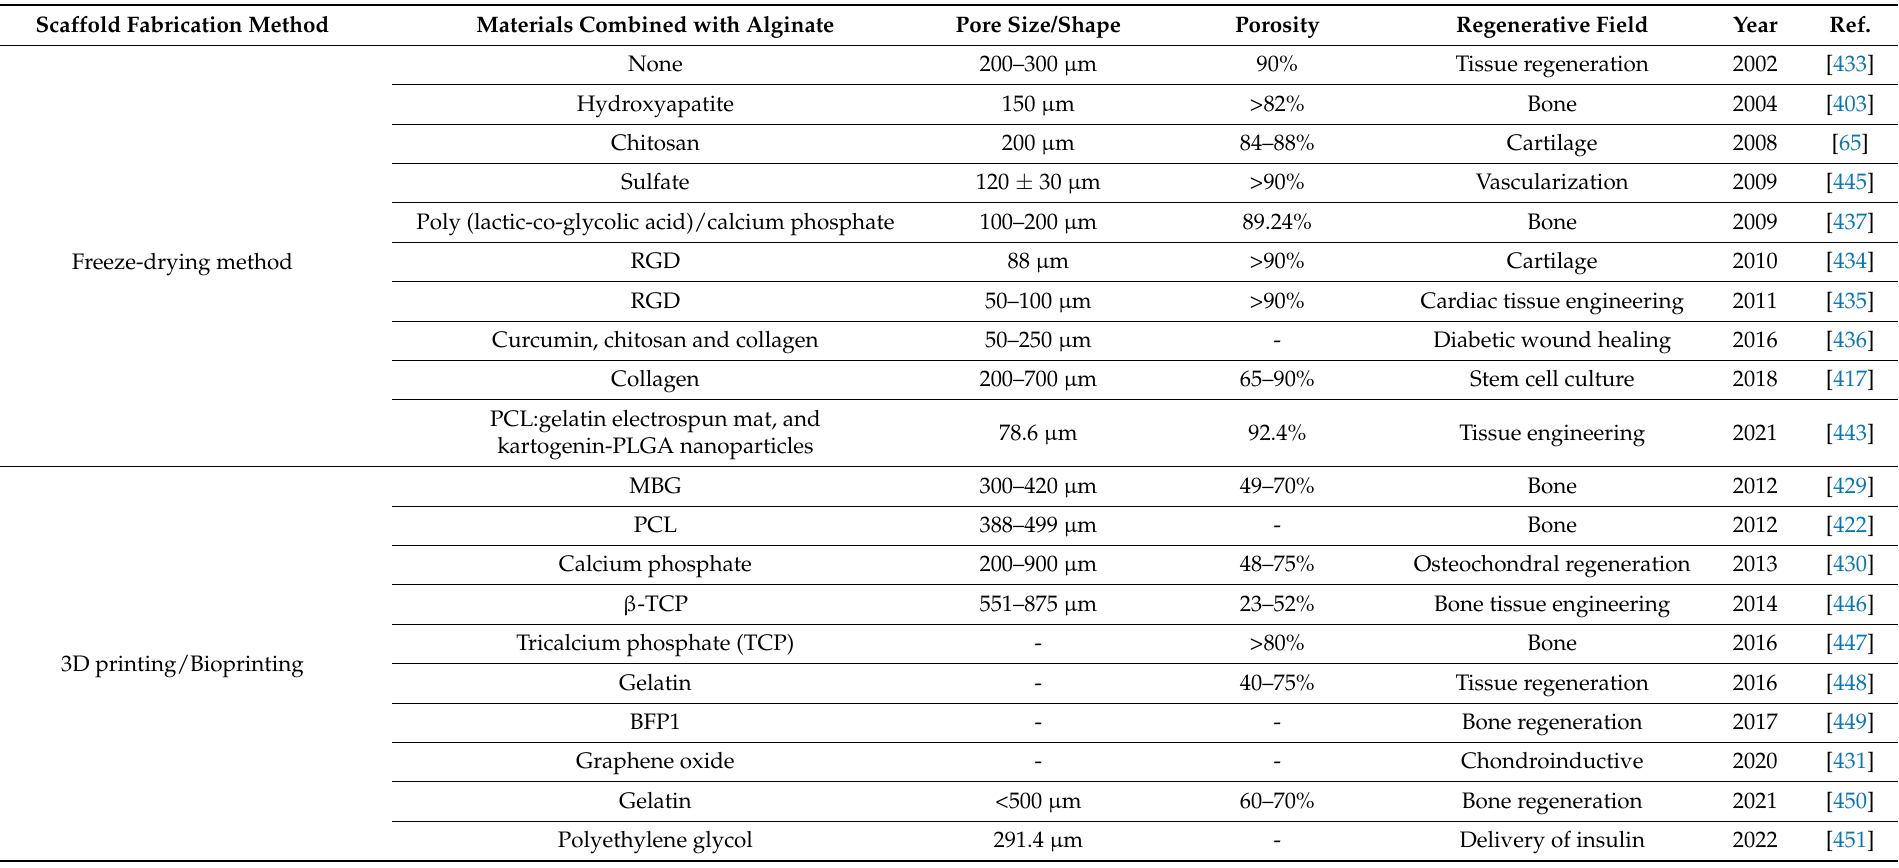
Table 5. Alginate-based scaffolds: fabrication method, materials combined with alginate, pore size/shape, porosity, regenerative field, year, and